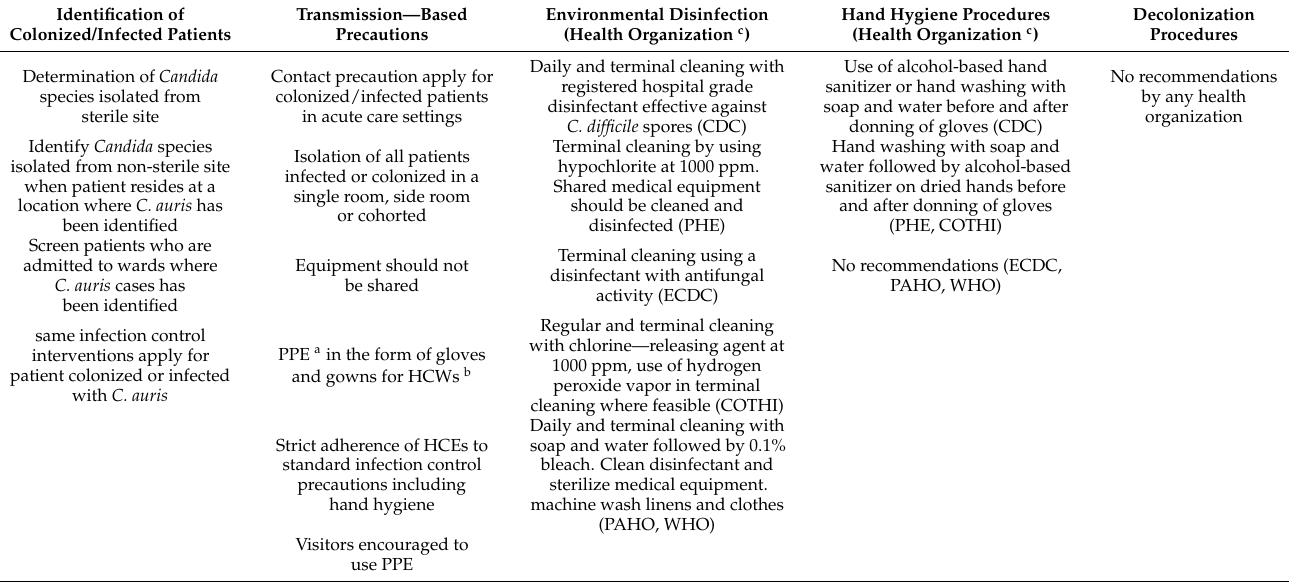
Table 2. Recommendation of infection control of C. auris